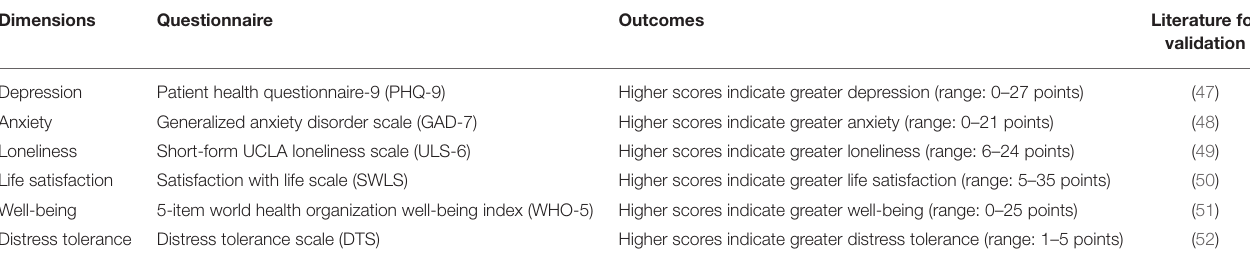
TABLE 2 | Questionnaire description.